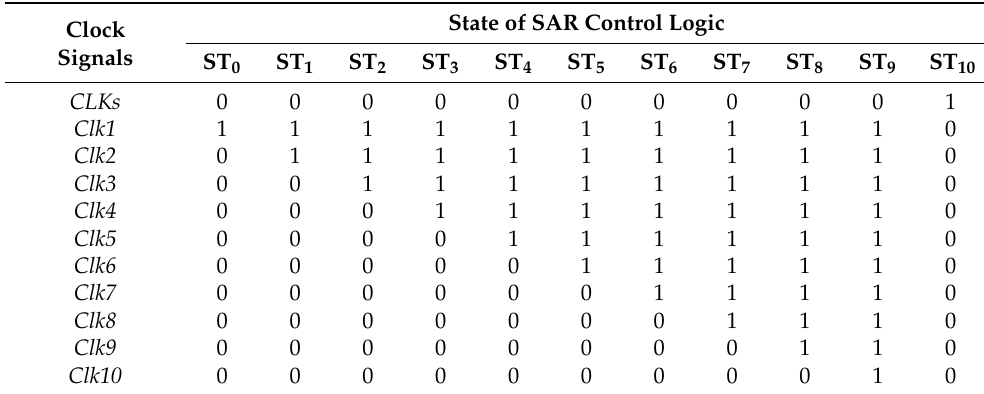
Table 1. State table of SAR control logic for controlling the DAC switches. Figure 11. Modified DAC control circuit with V outn / V outp , Clki, B ni / B pi , and D ni / D pi .